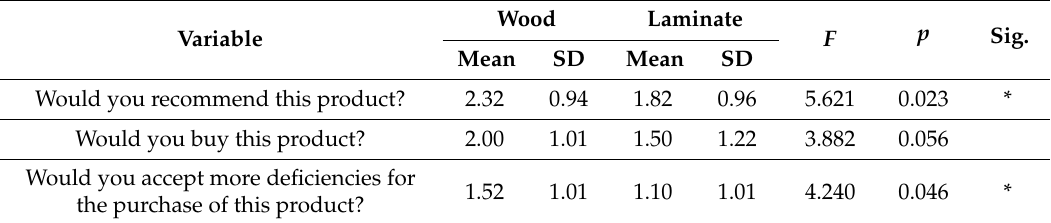
Table 2. Means (M), standard deviations (SD), F -values, p -values of the purchase decision for wood and laminate products *.